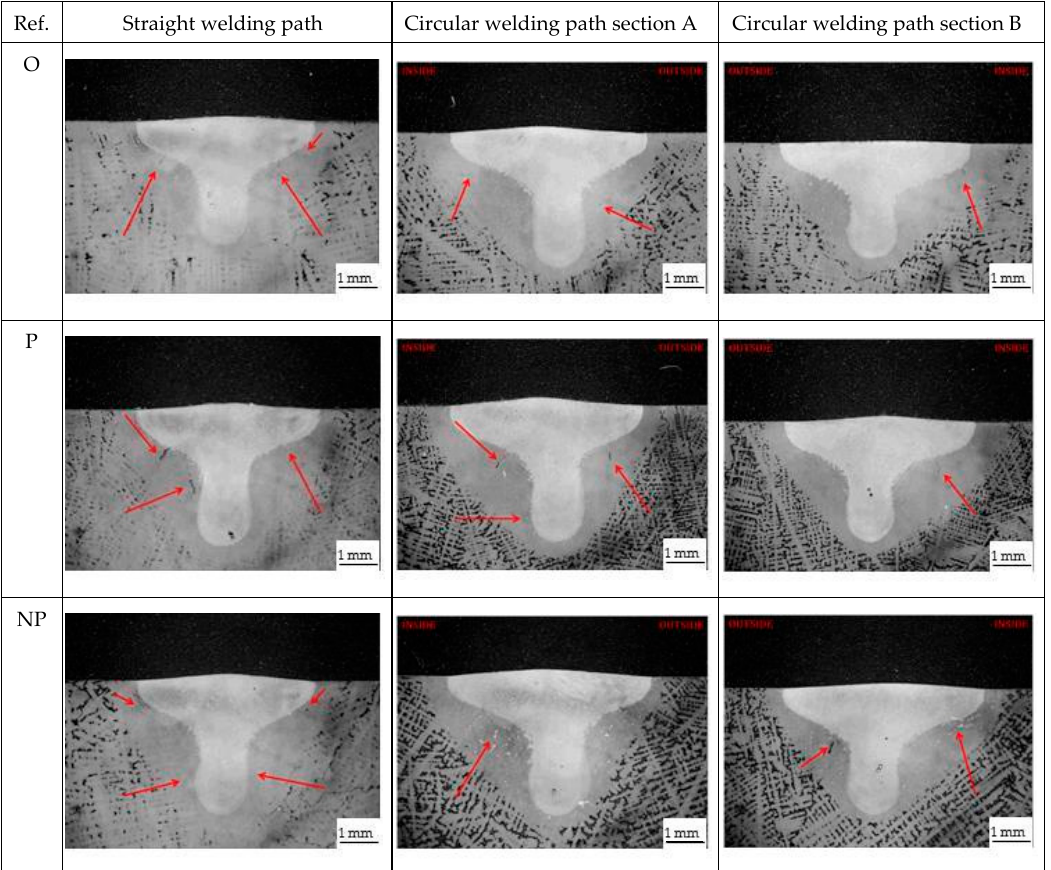
Figure 10. Cross-section of bead-on-plate tests of moulds O, P, and NP with 9 mm thickness. Laser power 2330